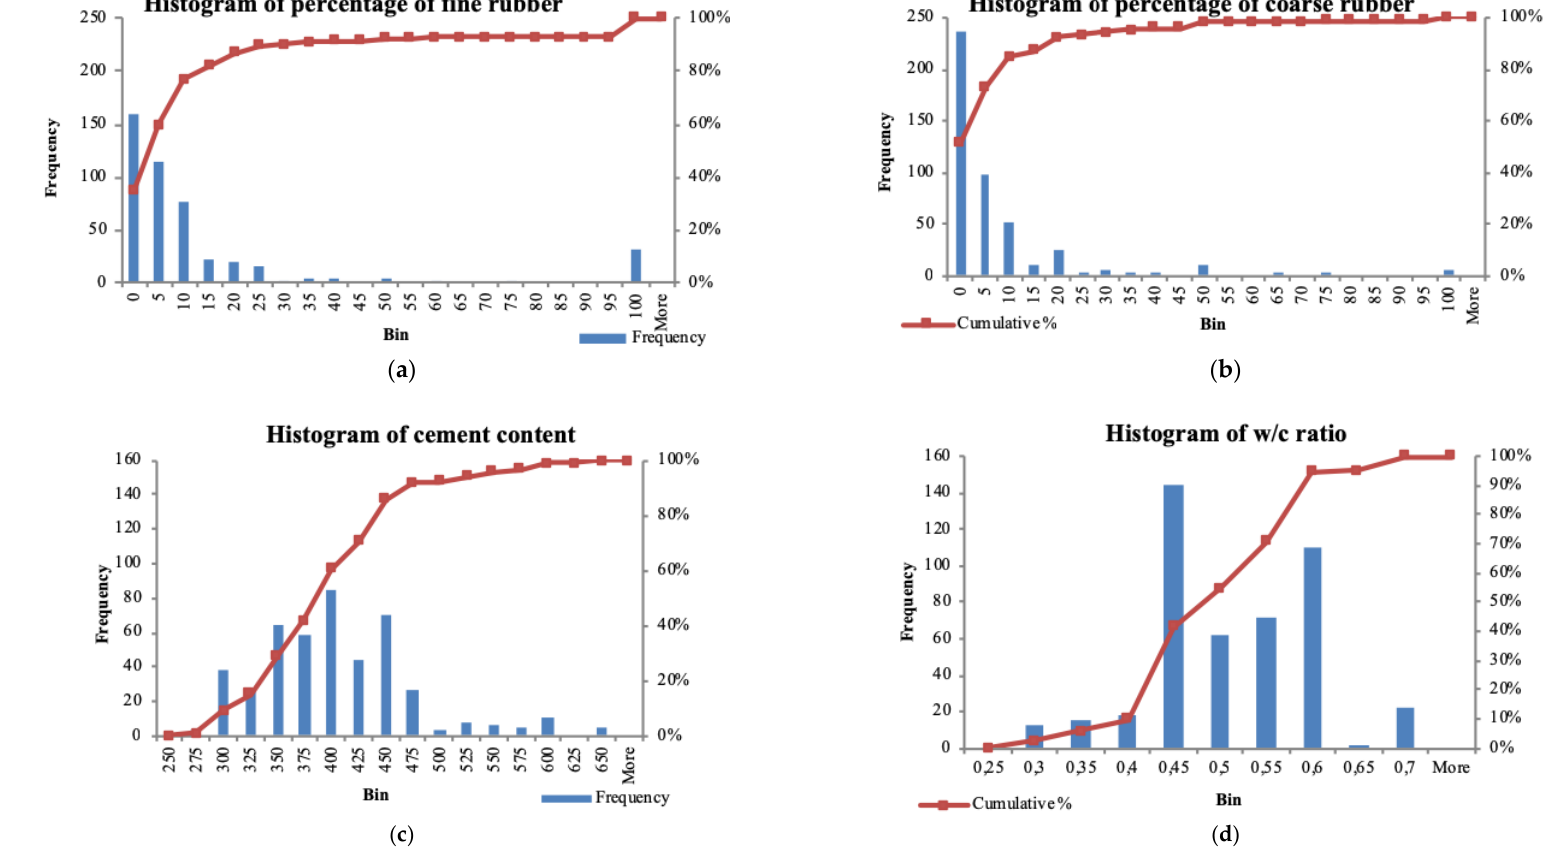
Figure 2. Histogram of: ( a ) percentage of fine rubber, ( b ) percentage of coarse rubber, ( c ) cement ratio, ( d ) w/c ratio.